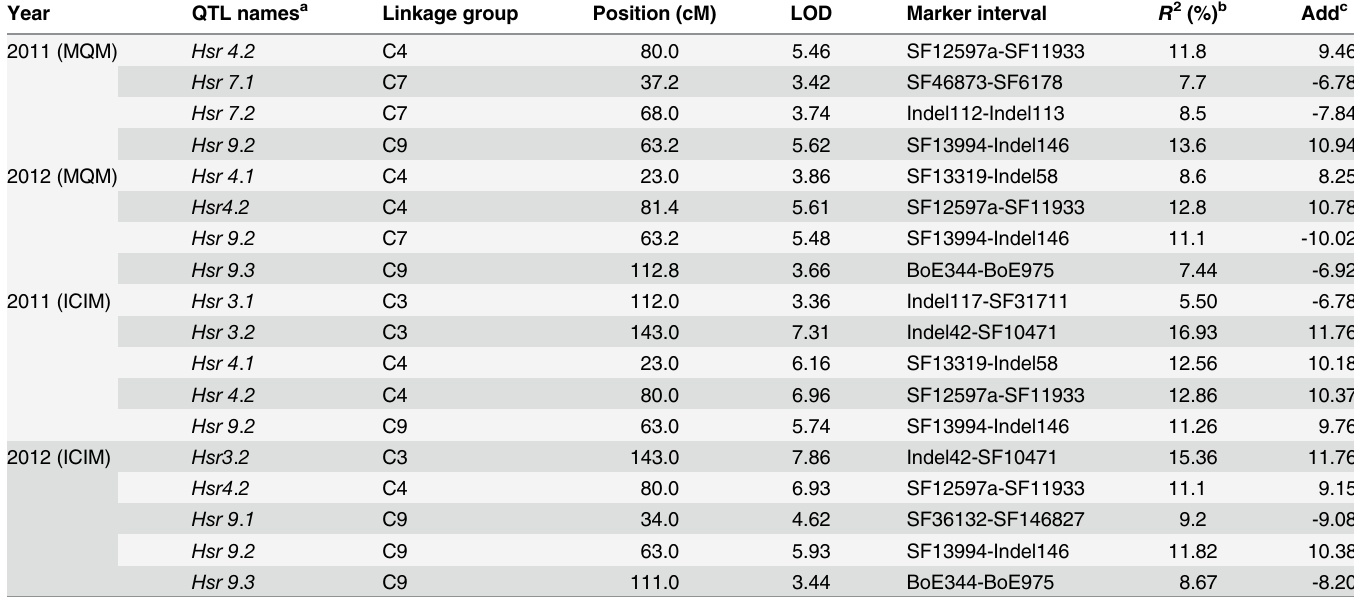
Table 5. Analysis of quantitative trait loci (QTLs) for head splitting resistance in a cabbage doubled haploid population using multiple-QTL map- ping (MQM) and inclusive composite interval mapping (ICIM)